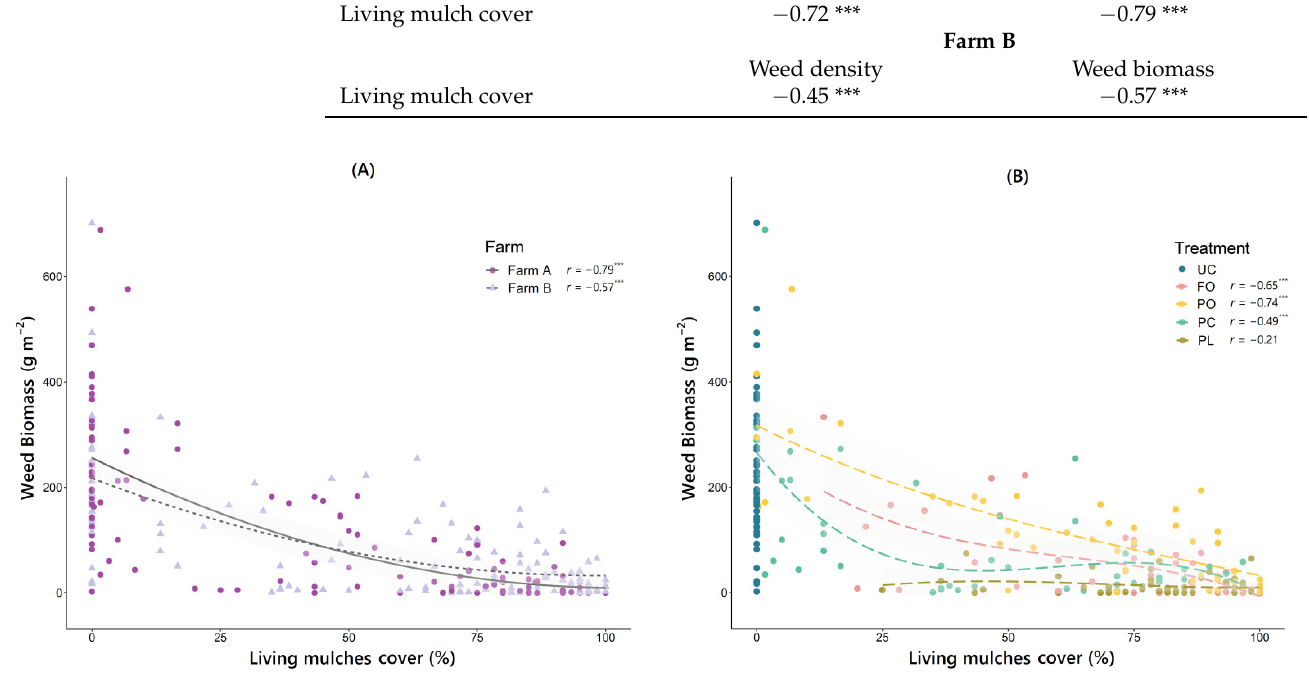
Figure 4. Correlations between living mulch cover (%) and weed biomass (g m − 2 ) considering the factor “farm” ( A ) and the factor “treatment” ( B ). Spearman’s correlation coefficient ( r ) and the significance level (no asterisks, non-significant; *** p < 0.001) are indicated for each of the estimated correlations. UC, untreated control; FO, Festuca ovina living mulch; PO, Pilosella officinarum living mulch; PC, Plantago coronopus living mulch; PL, Plantago lanceolata living mulch. While FO and PO living mulch covers were strongly correlated with weed biomass, this relationship was weaker in the two Plantago species, especially in PL living mulch, where the observed correlation was not even significant. These differentiated responses therefore conditioned the average weed suppression reached by each living mulch. For example, PC living mulch resulted in high weed suppression (71%) with intermediate levels of cover (54%) on farm B, while PO living mulch required much higher cover (83%) to reach a similar level of suppression (68%) (Table 6). When the correlation between living mulch cover and the ratio weed biomass/weed density was analyzed, contrasting responses were also observed according to the type of living mulch (Figure 5). In this case, it was the FO and PL living mulches that showed a weaker correlation, exhibiting, on average, a markedly lower ratio than that observed for PO and PC living mulches (Table